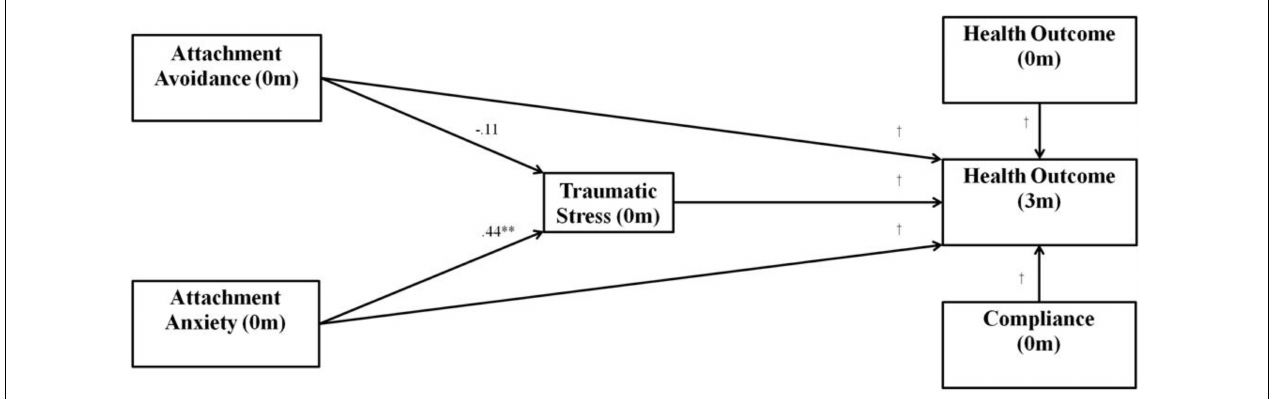
FIGURE 2 | Multivariate structural equation model used for path analysis with values representing standardized regression coefficients. The hypothesized pathways include attachment anxiety and avoidance having indirect effects on health outcome variables through traumatic stress. ∗∗ p < 0.01, m, months, † values are presented in Table 2 . Indirect effects for model are shown in Table 3 .